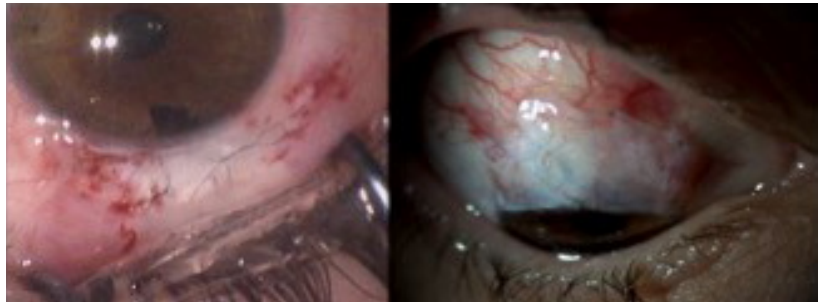
Figure 2: Suture of the scleral flap (left) and conjunctival graft